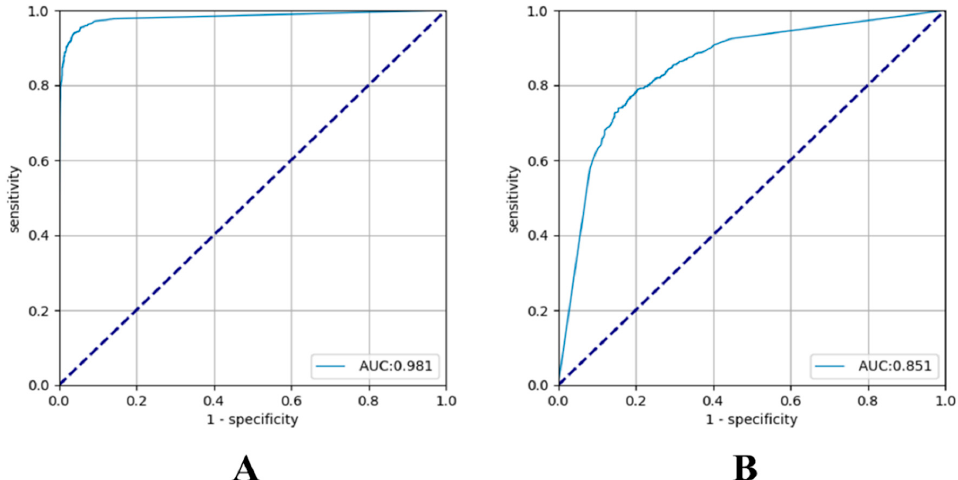
Figure 1. Receiver operating characteristic (ROC) curves of lesion-based visual geometry group (VGG)-16 for the test dataset with their areas under the curves (AUCs). ( A ) Early gastric cancer (EGC) detection model and ( B ) EGC depth prediction model.